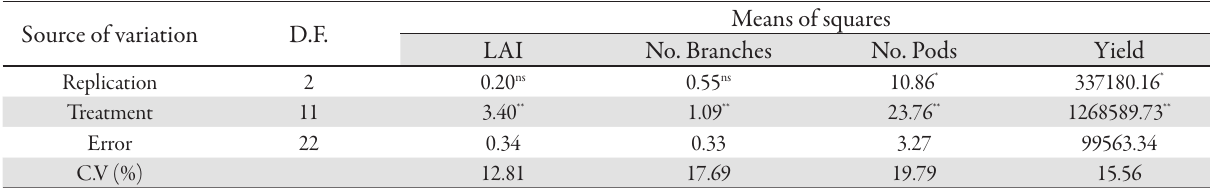
treatments of weed interference and weed free periods Source of